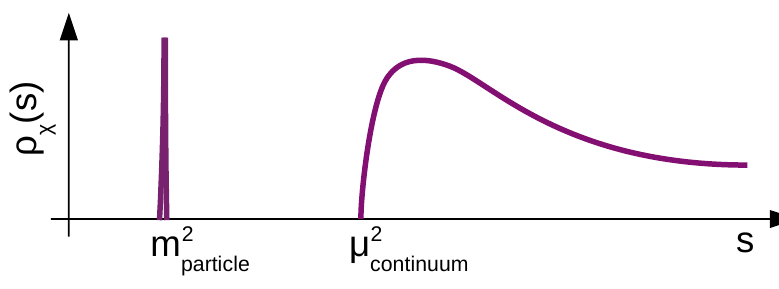
Figure 1 . A cartoon of a typical fermionic spectral density. The delta function corresponds to a massive particle in the spectrum, while the continuous part indicates a fermion continuum.